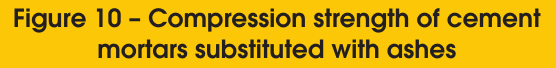
Figure 10 – Compression strength of cement mortars substituted with ashes